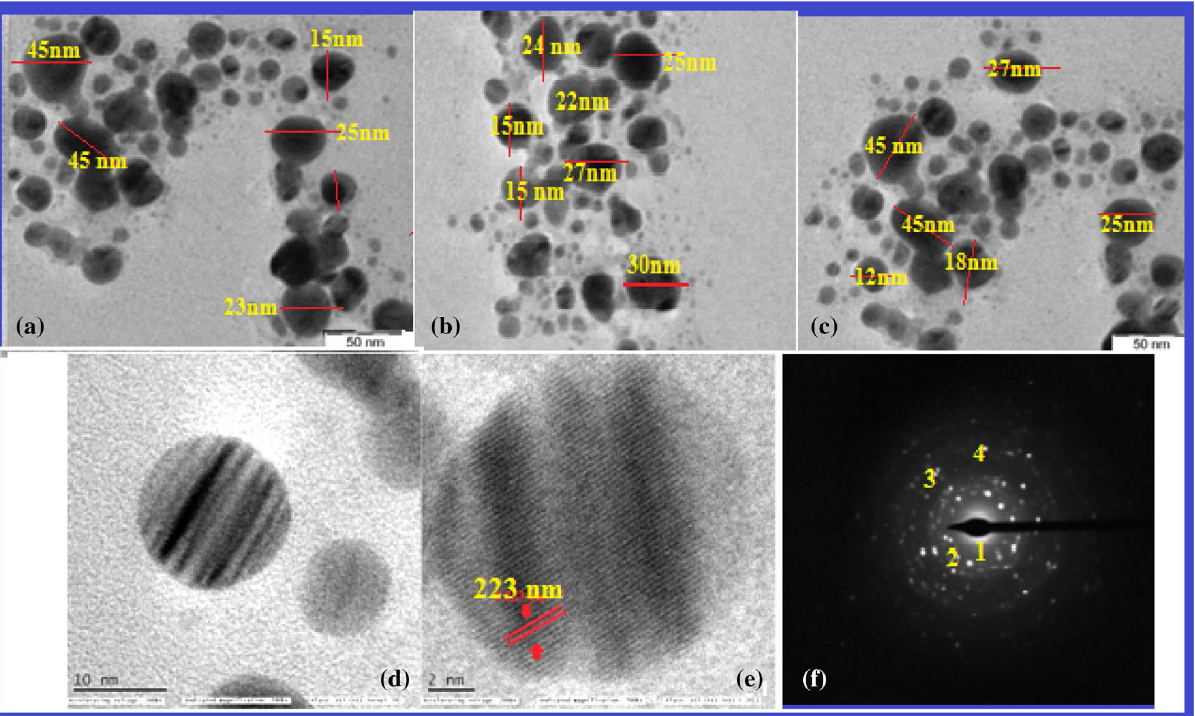
Figure 4. TEM images of Ds-AgNPs at magnification of ( a ) 50 Kx, ( b )50 Kx, ( c ) 50Kx, ( d ) 280Kx, ( e ) 700Kx, ( f ) SAED pattern showed four diffraction